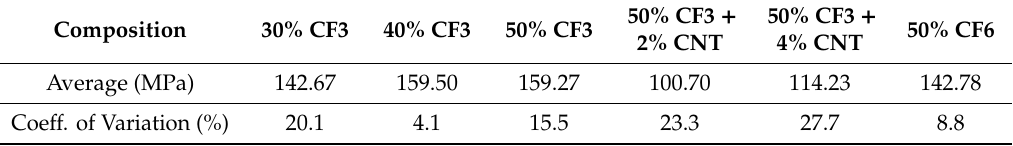
Table 2. Averageandcoefficientofvariationofultimatetensilestrengthfordifferentspecimencompositions.